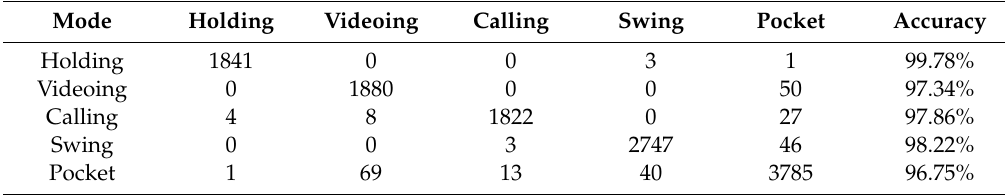
Table 2. Confusion matrix of the C4.5 classification